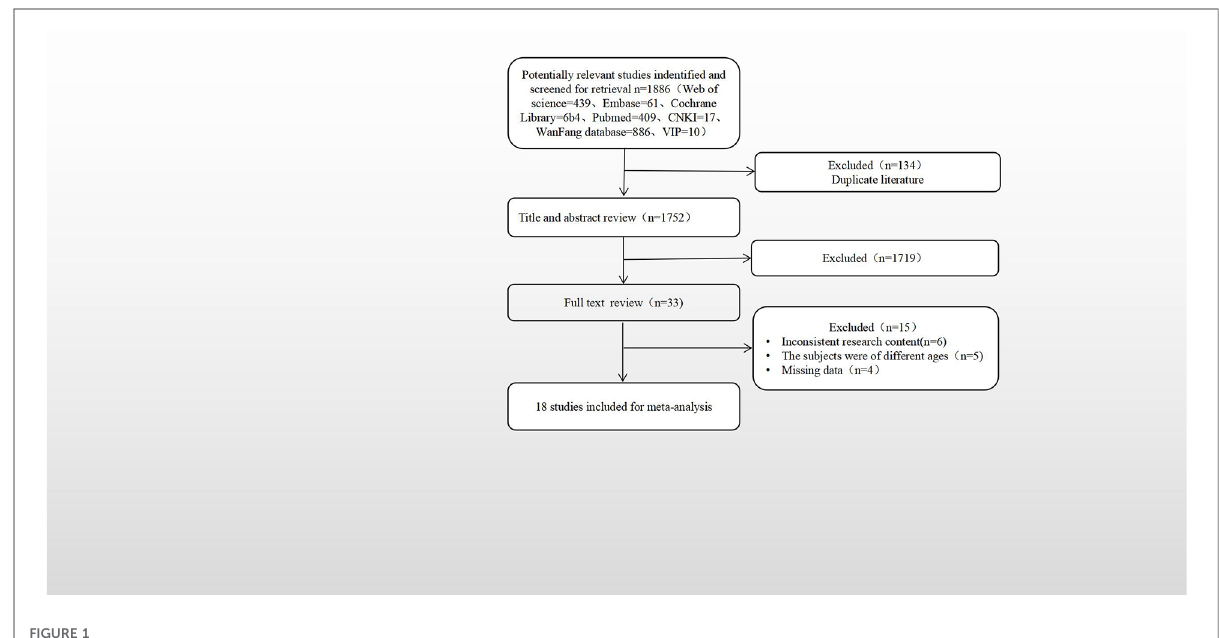
FIGURE 1 Flow diagram for the selection of included